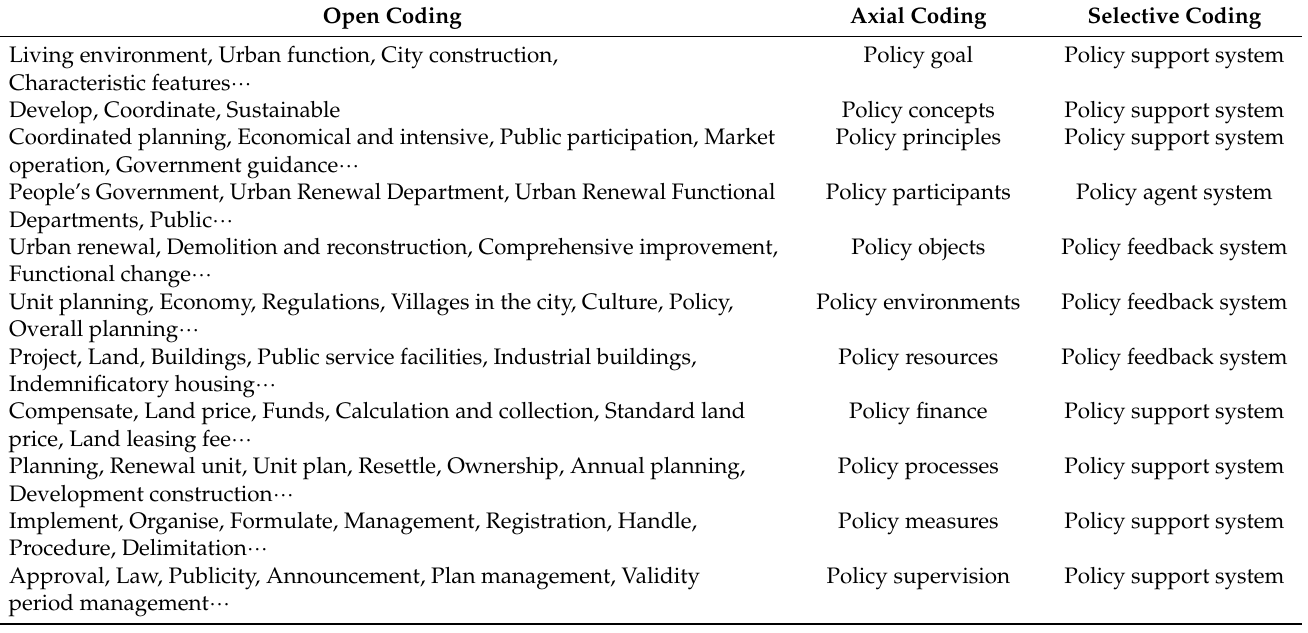
Table 7. Axial coding and selective coding table